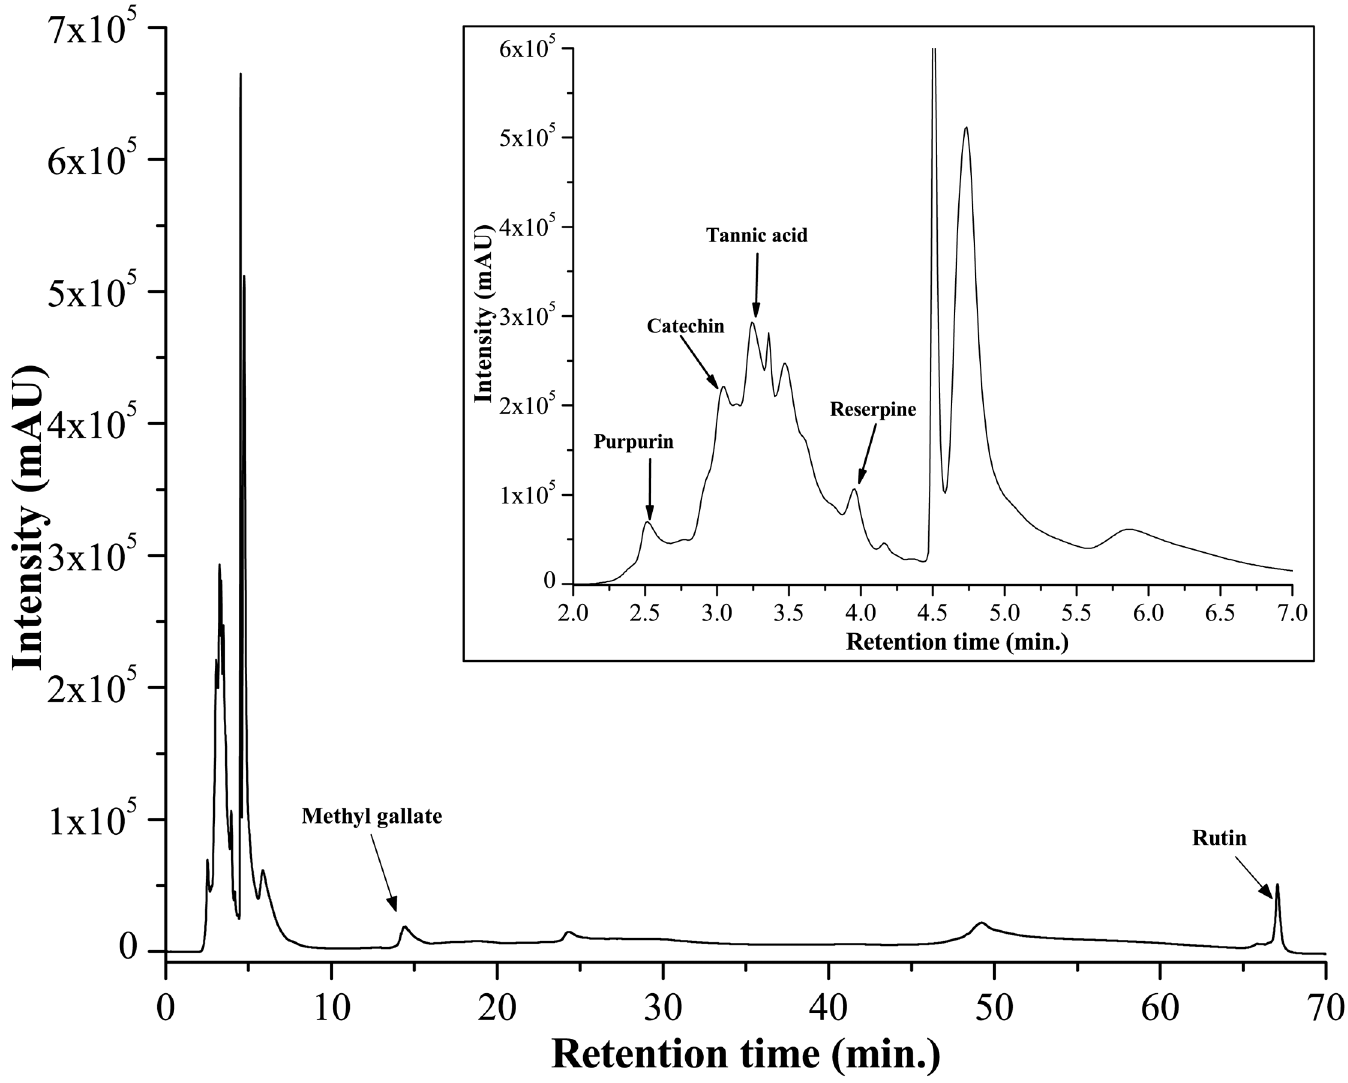
Fig 11. HPLC chromatogram of DBME. Inset shows expanded region of the chromatogram with retention time of 2 – 6 minutes. Peaks marked signify the retention peak of purpurin (2.5 min), catechin (3.04 min), tannic acid (3.24 min), reserpine (3.97 min), methyl gallate (14.55 min) and rutin (67.08 min).